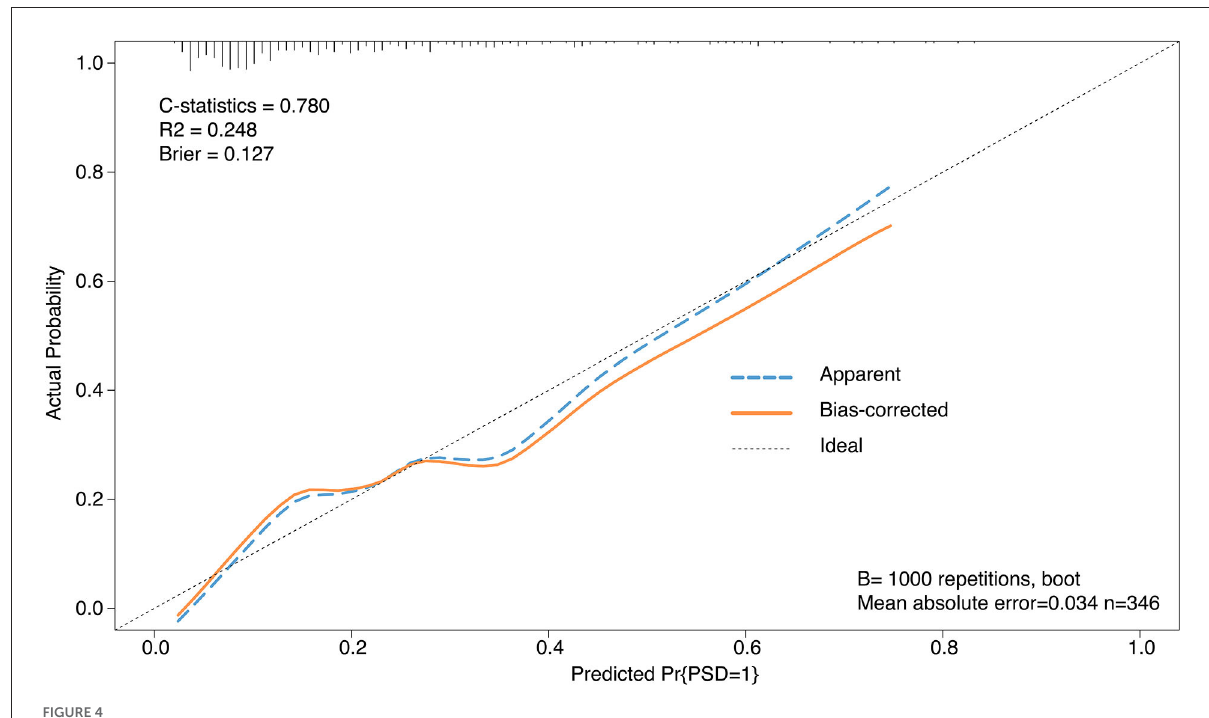
FIGURE4 The calibration curves for the